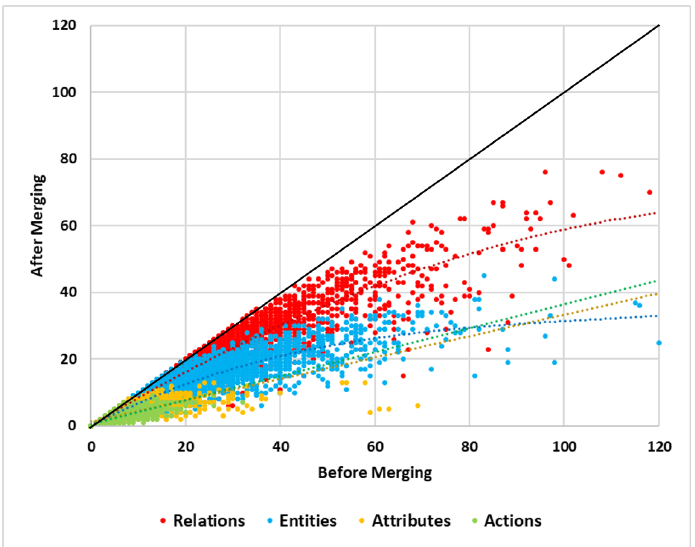
Figure 12. A scatter plot showing the number of entities, attributes, actions, and relations, before and after merging regional graphs. Trends show a below-linear relation for most